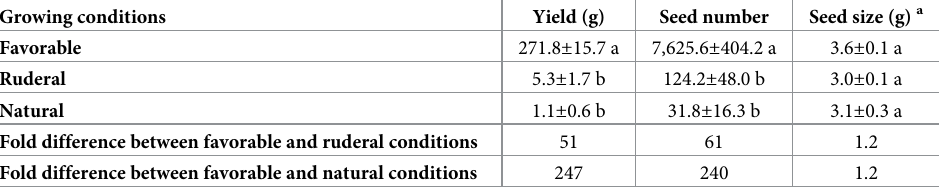
Table 7. Comparison (mean ± SE) of seed production characteristics (yield per plant, seed number per plant, and seed size) of Aomori 1 population grown under favorable, ruderal, and natural conditions.